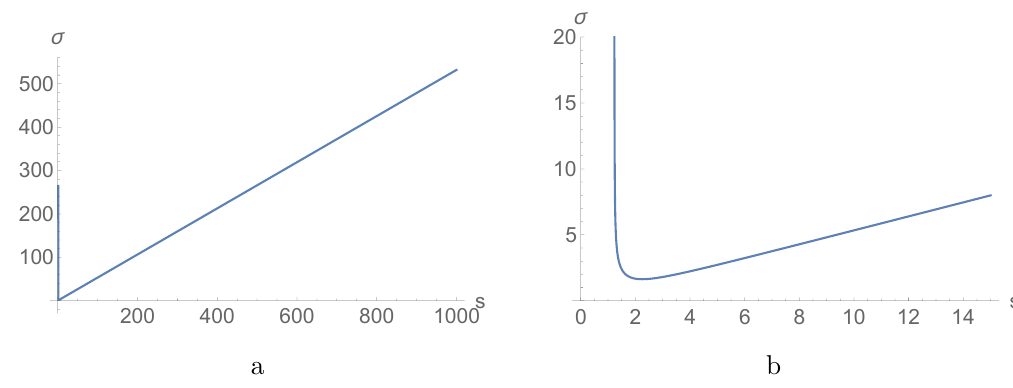
Figure 3 . (a) Plot of (cid:27) versus r + =‘ for ~ Q = 10. (b) The same plot, zoomed in to the small r + =‘ region. One can see that (cid:27) turns around before ever becoming